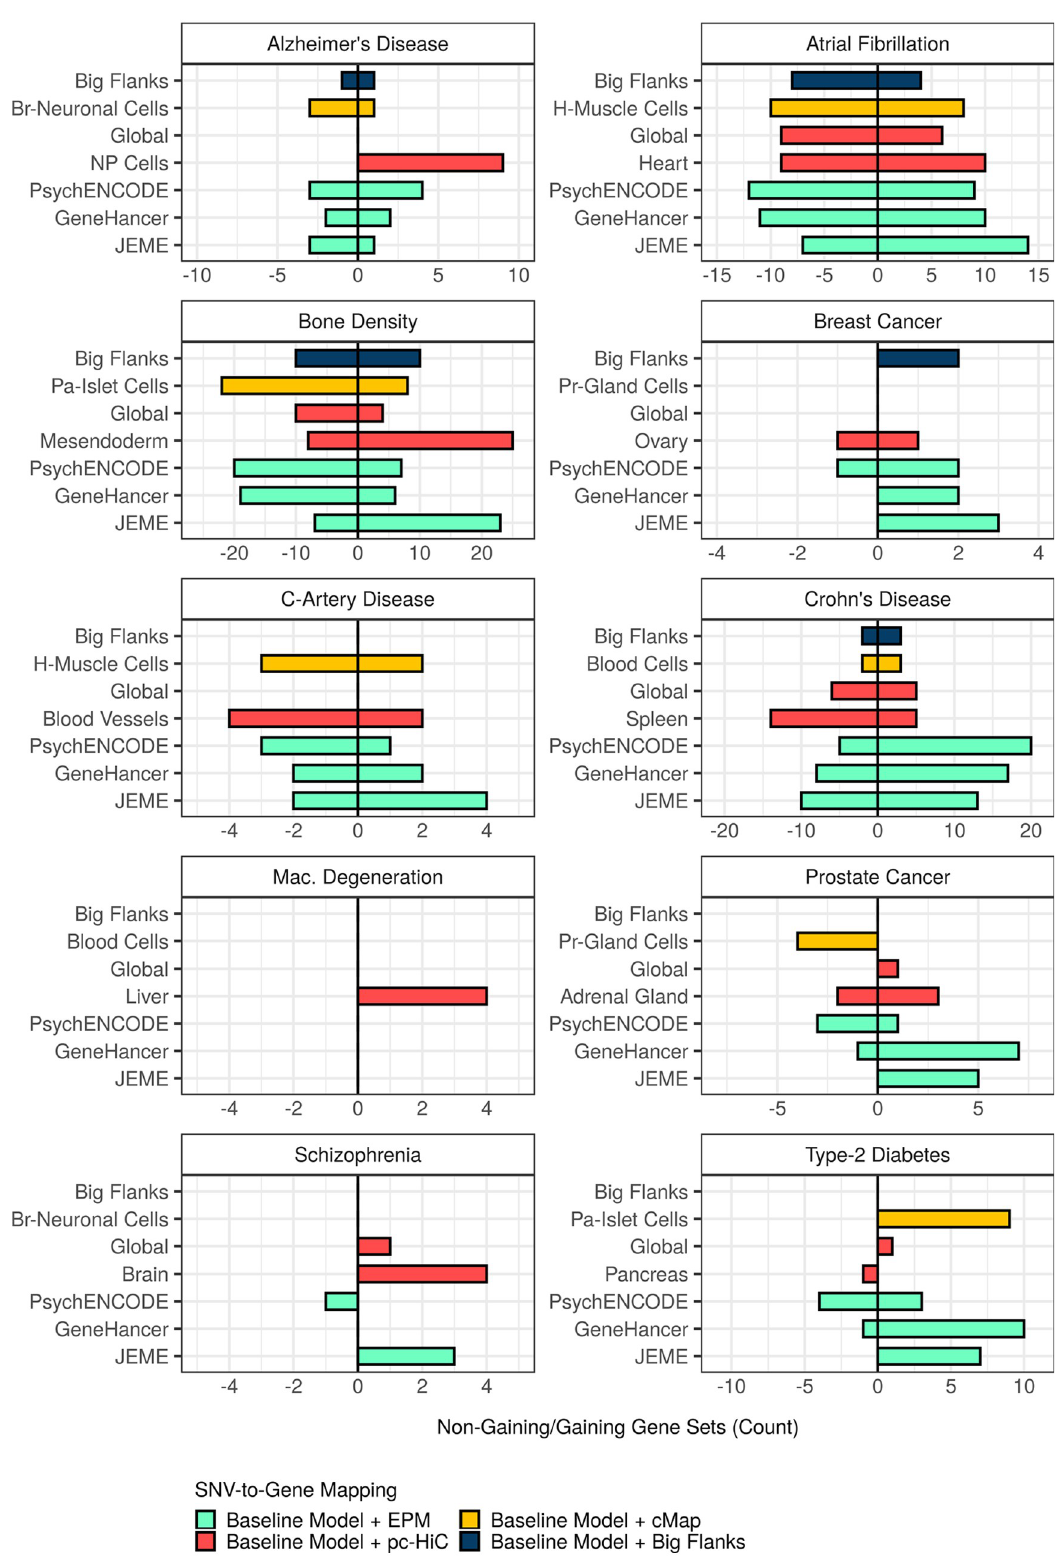
Fig 5. Gene sets detected as significant with some augmentation, do not necessarily gain from that augmentation. Significant gene sets detected for selected augmentations for each phenotype were stratified according to whether they gained from augmentation (that is, demonstrated a stronger enrichment for phenotype association with, than without, augmentation) or not. A bar directed to